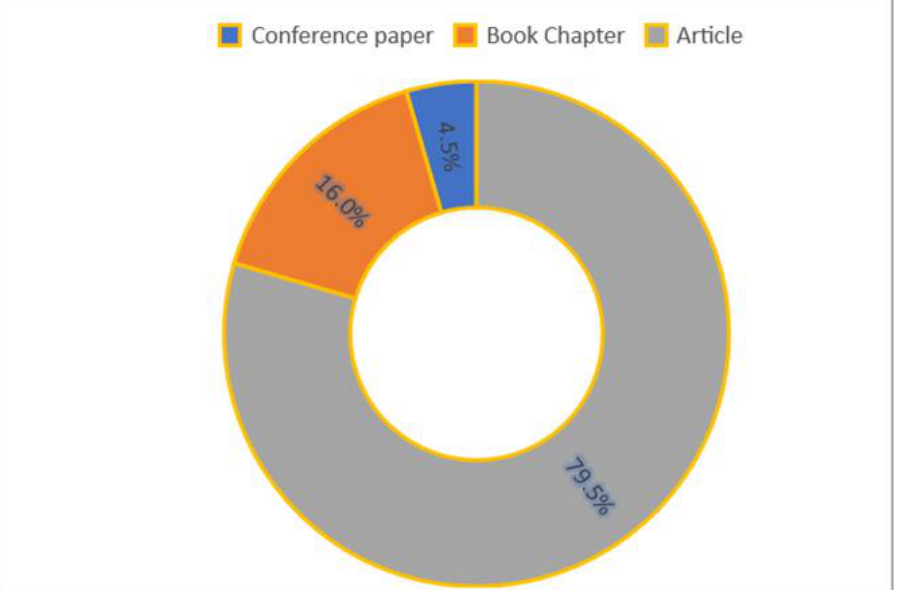
Figure 3. Distribution of data by document type.